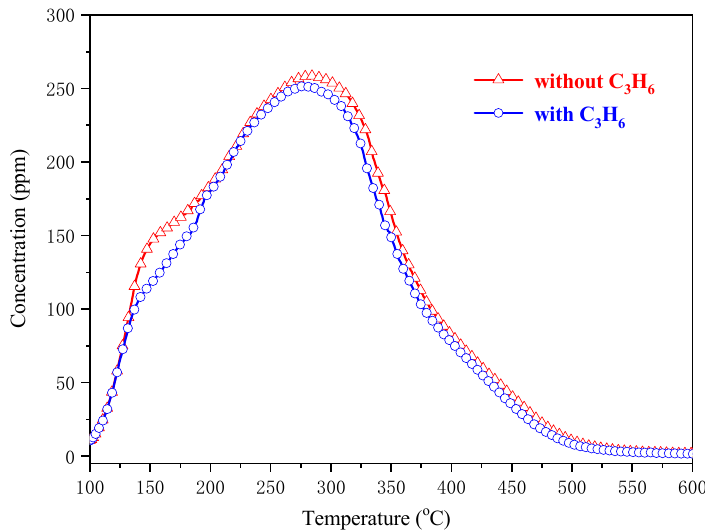
Figure 6. NH 3 -TPD profiles over Cu-SAPO-34 catalyst with or without C 3 H 6 .